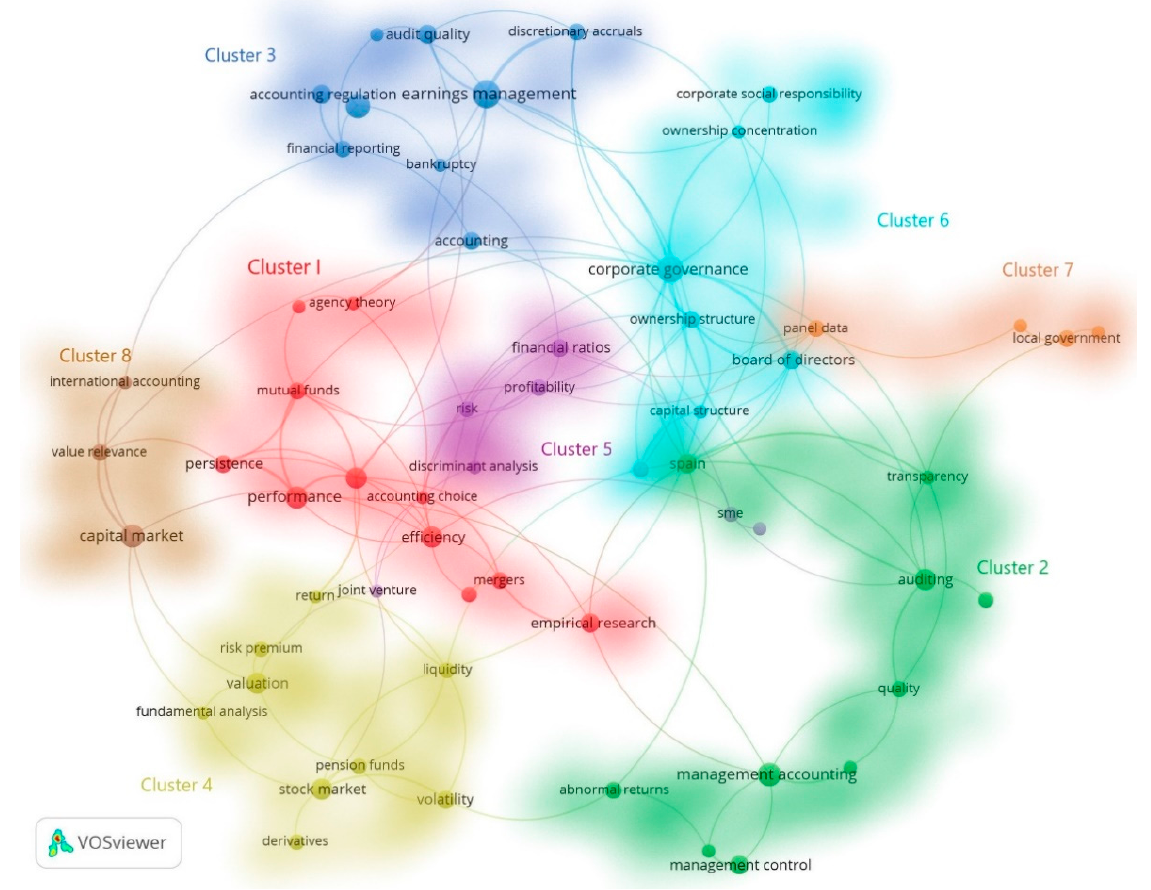
Figure 5. Co-occurrence of author keywords on SJFA.